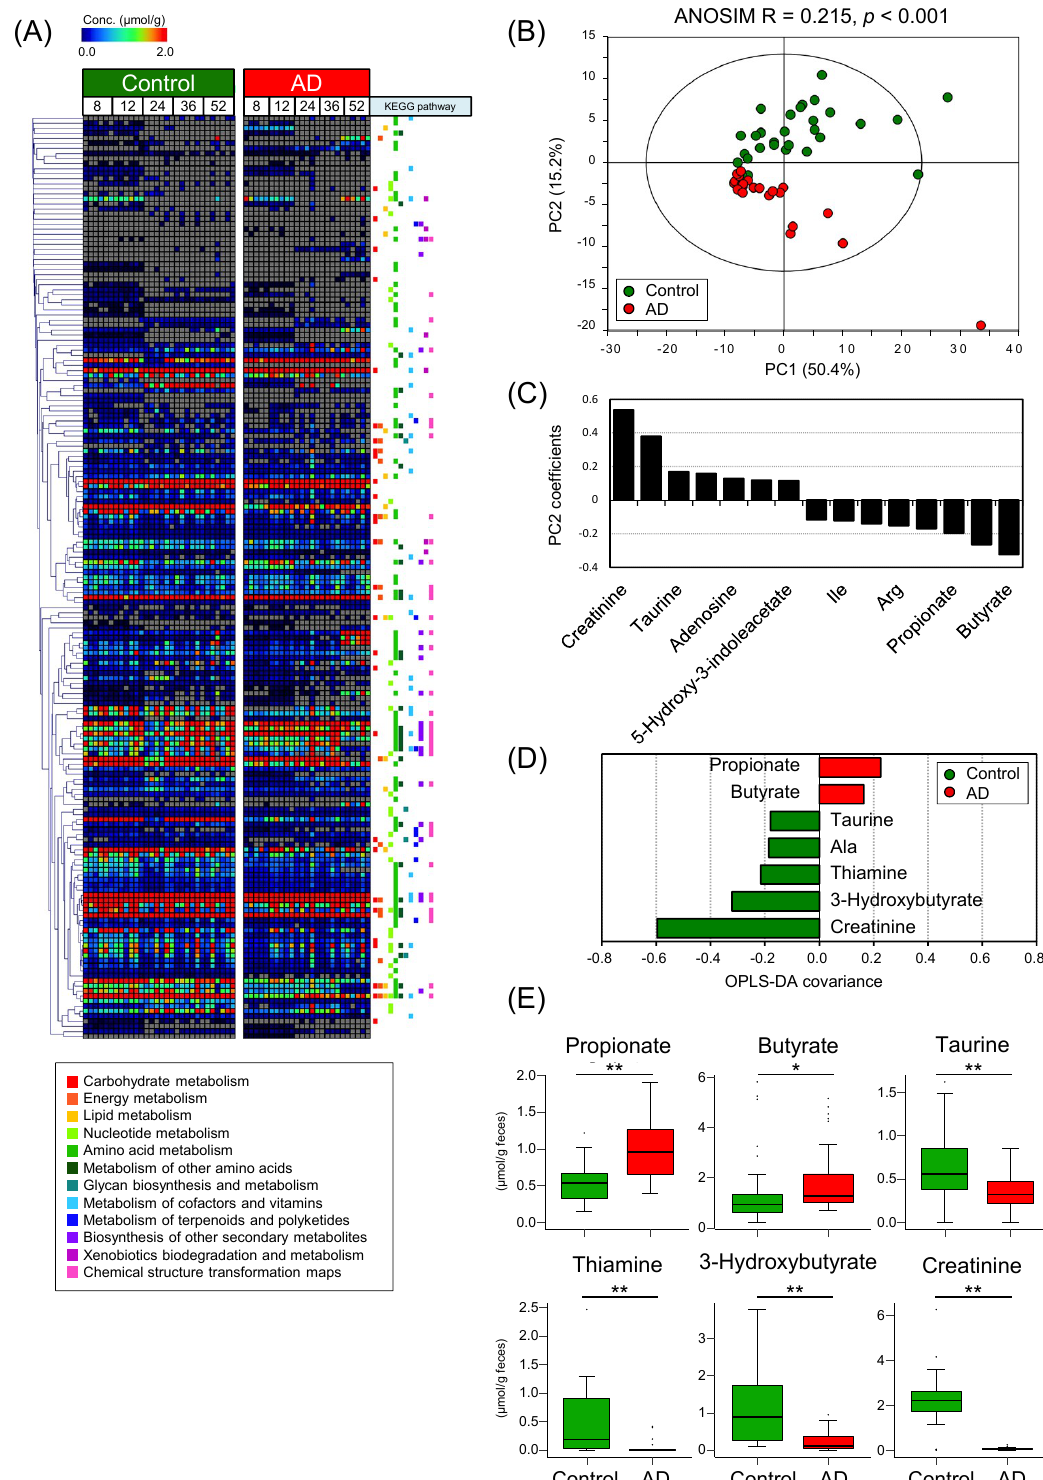
Figure 2. AD consumption alters intestinal metabolome profiles in mouse. ( A ) Heatmap showing the concentrations of quantified metabolites using a rainbow scheme. Gray indicates the concentrations of metabolites that fell below the detection limit. Kyoto Encyclopedia of Genes and Genomes (KEGG) pathways that each metabolite belongs to are shown to the right of the heatmap. Labels at the top of the panel indicate dietary group and mouse age (in weeks); ( B ) PCA of the intestinal metabolome profiles normalized by Pareto and analysis of similarity (ANOSIM). The ellipse denotes the 95% significance limit of the model, as defined by Hotelling’s t -test; ( C ) Bar graph showing PC2 values for